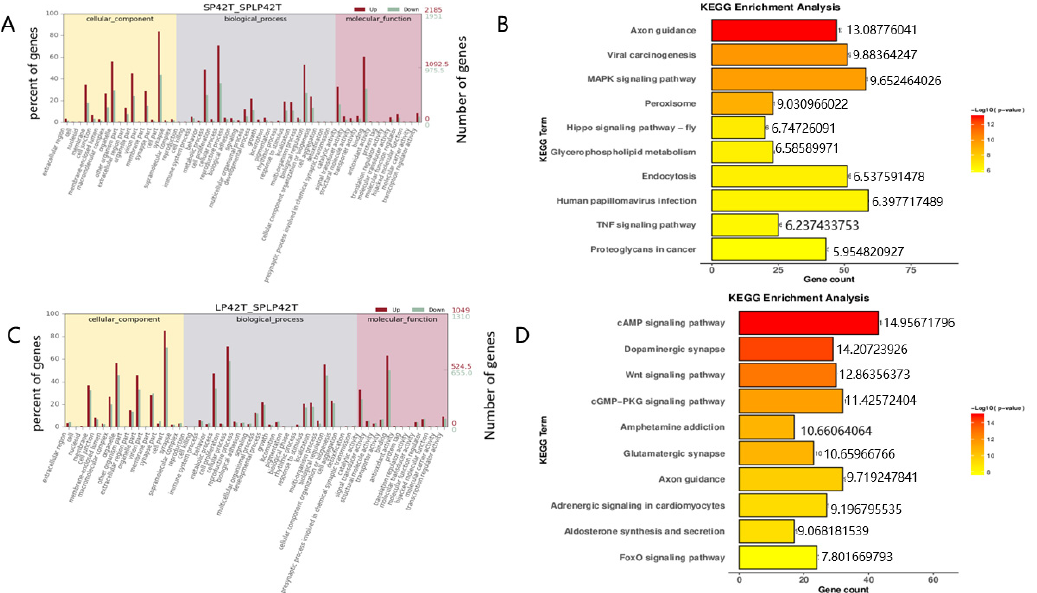
Figure 5. An analysis of GO and KEGG enrichment in the thyroid gland was performed. ( A ) Analysis of GO function of DE-lncRNAs in SP42 and SPLP42. ( B ) Ten major KEGG enrichment pathways of DE-lncRNAs were observed between SP42 and SPLP42. ( C ) Analysis of GO function of DE-lncRNAs in LP42 and SPLP42. ( D ) Ten major KEGG enrichment pathways of DE-lncRNAs were observed between LP42 and